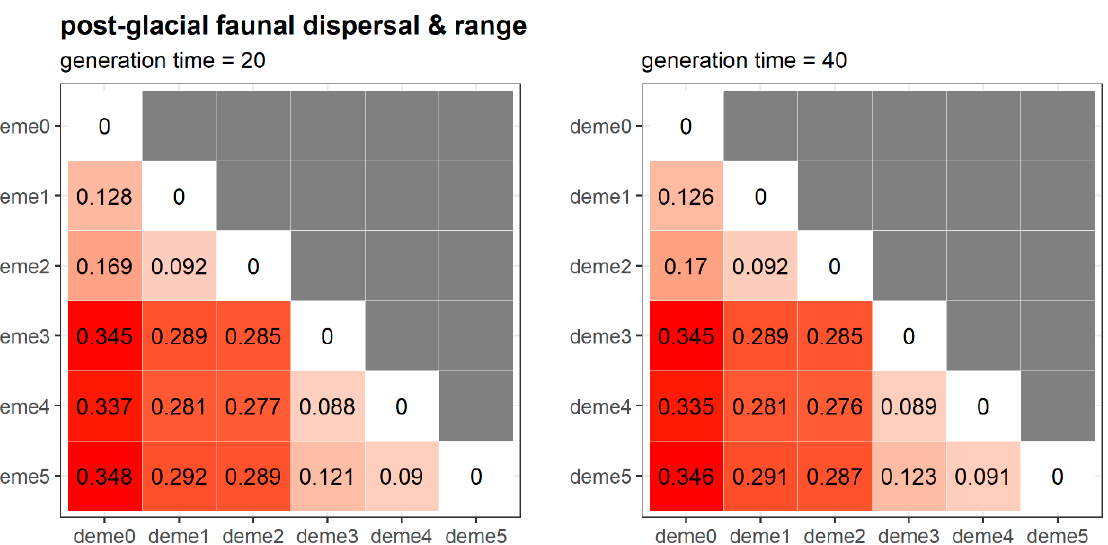
Figure A2. The mean pairwise Fst values calculated across 100 replicate simulations of a post-glacial faunal-mediated dispersal scenario (“fd + exp” in Table A1). This scenario of faunal dispersal assumes that deme0 was established by propagules from deme1 6kya, and a symmetric distance-weighted migration matrix.